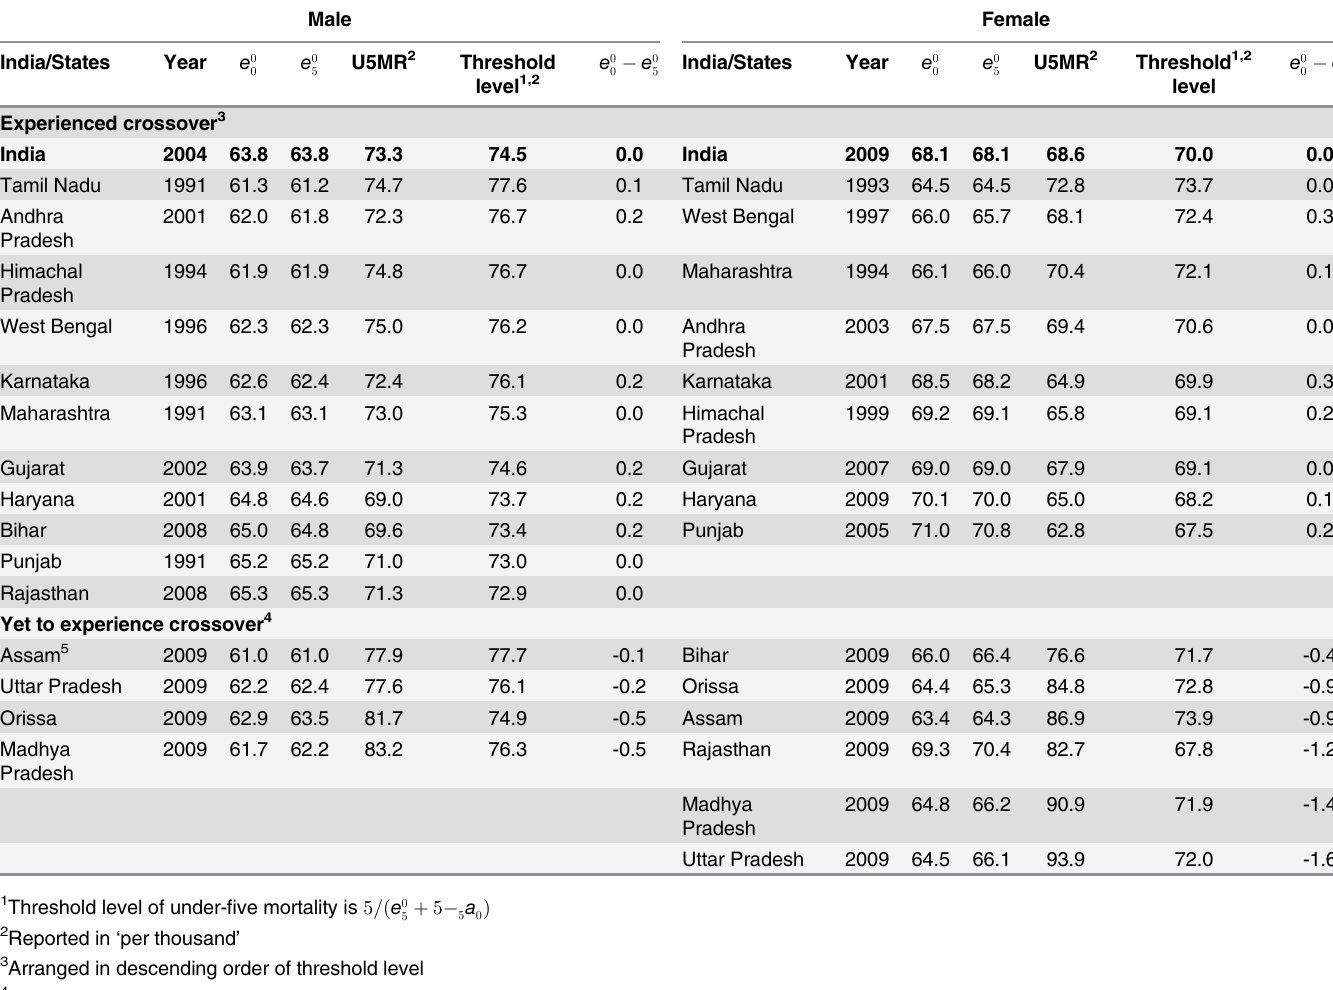
Table 1. Year of crossover, levels of life expectancies at ages zero and five, under-five mortality rate and its threshold level by sex, India and states. Male